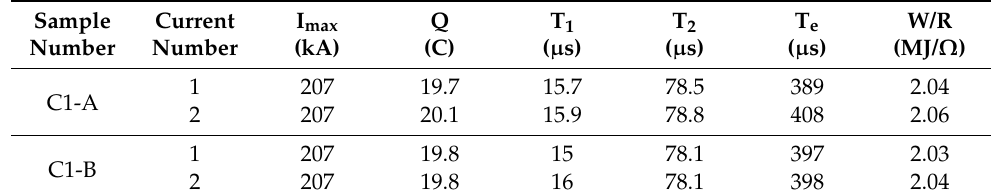
Table 3. Current parameters during the tests of the 2 samples of configuration 1 (segmented diver- ter